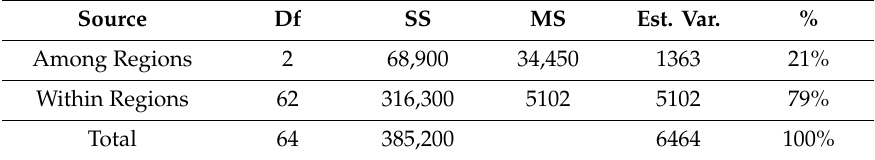
Table 3. Hierarchical partitioning of the genetic variation within and among sample regions (AMOVA). Source Df SS MS Est. Var. % Among Regions 2 68,900 34,450 1363 21% Within Regions 62 316,300 5102 5102 79% Total 64 385,200 6464 100%